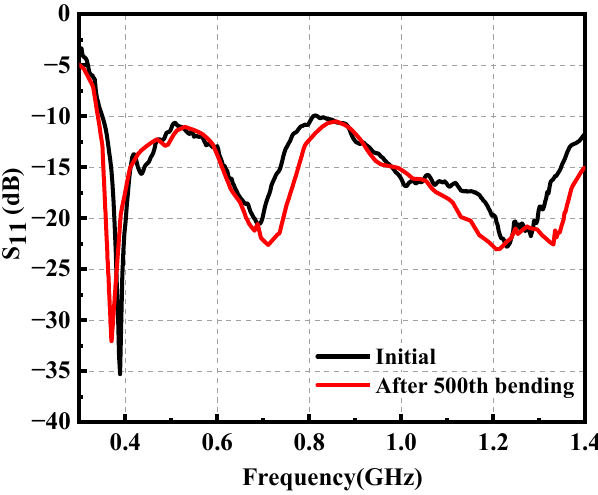
Figure 14. The reflection coefficient of the proposed antenna before and after bending.